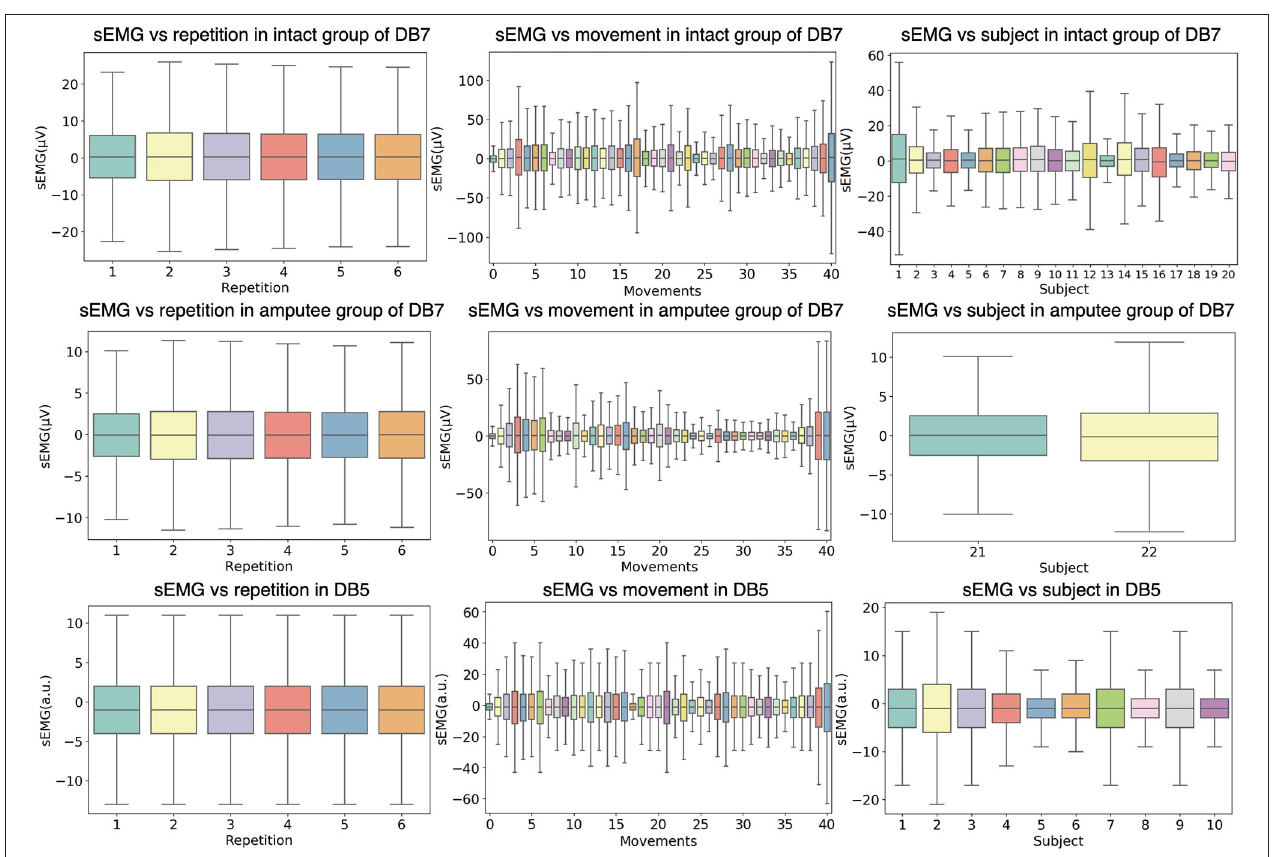
FIGURE 3 | Distributions of the sEMG signal amplitudes grouped by different experiment conditions. The first two rows show data from the intact and amputee groups from DB7, while the third row shows DB5. The first column groups the amplitudes from all movements and subjects by repetition; the second column from all repetitions and subjects by movement; the third column from all repetitions and movements by subject. The horizontal lines in the middle of each box mark the median; the edges denote the first and third quartiles; the whiskers cover approximately 2.7 times the standard deviation.